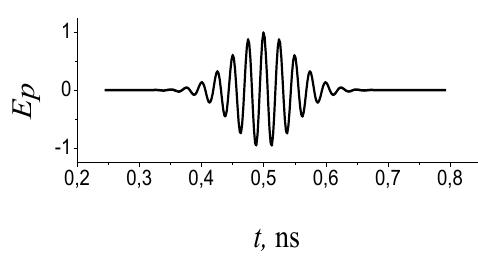
Fig. 2. Short pulse with the central frequency 40 GHz and Gaussian envelope.